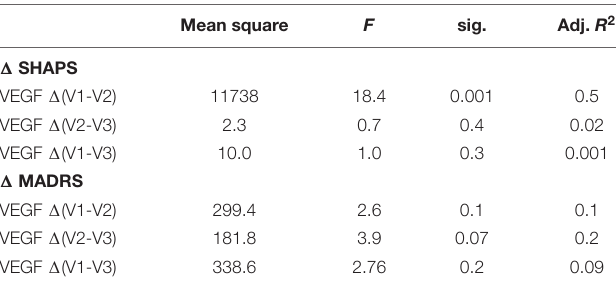
TABLE 3 | Correlations between serum VEGF level changes and phenotypic score differences. Mean square F sig. Adj. R 2